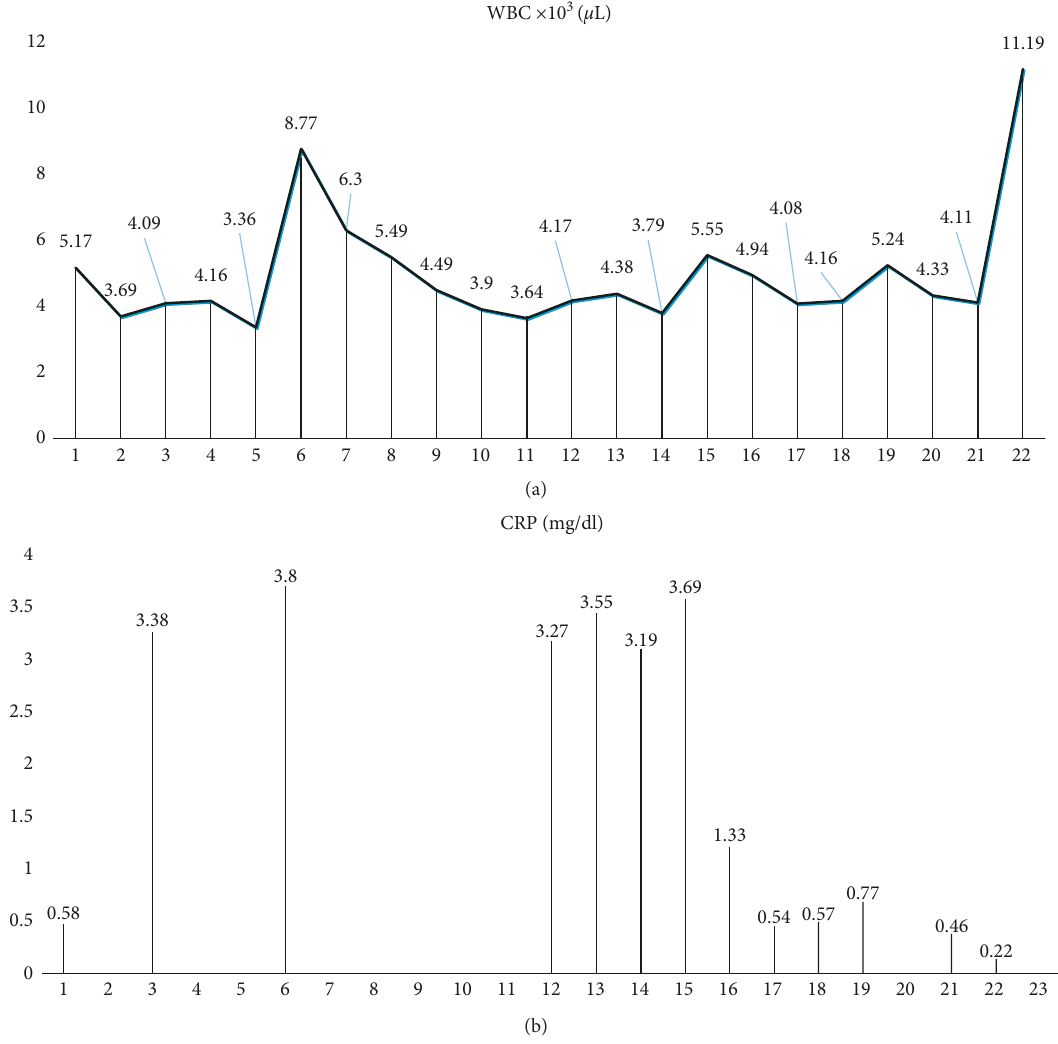
Figure 2: Kinetics of WBC and acute phase reactant during the clinical course of